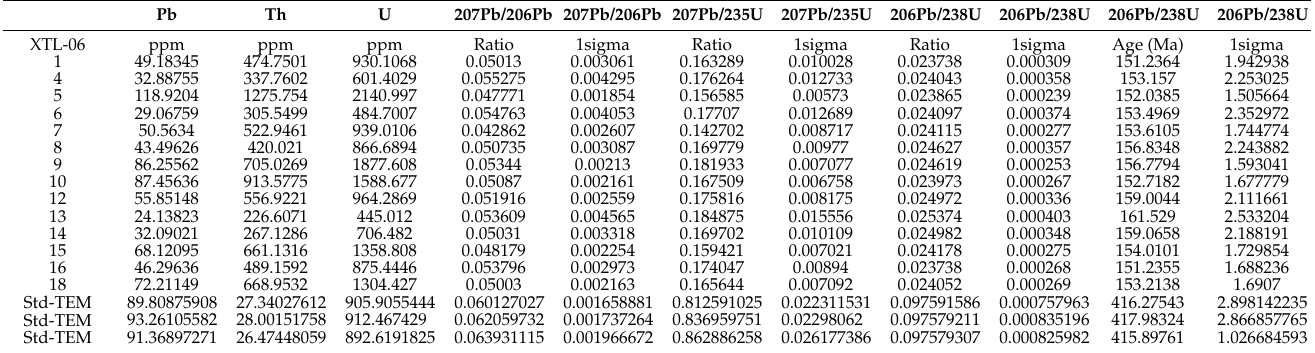
Table 7. LA-ICPMS U–Pb zircon dating data of the XTL06 from the Xintianling deposit.